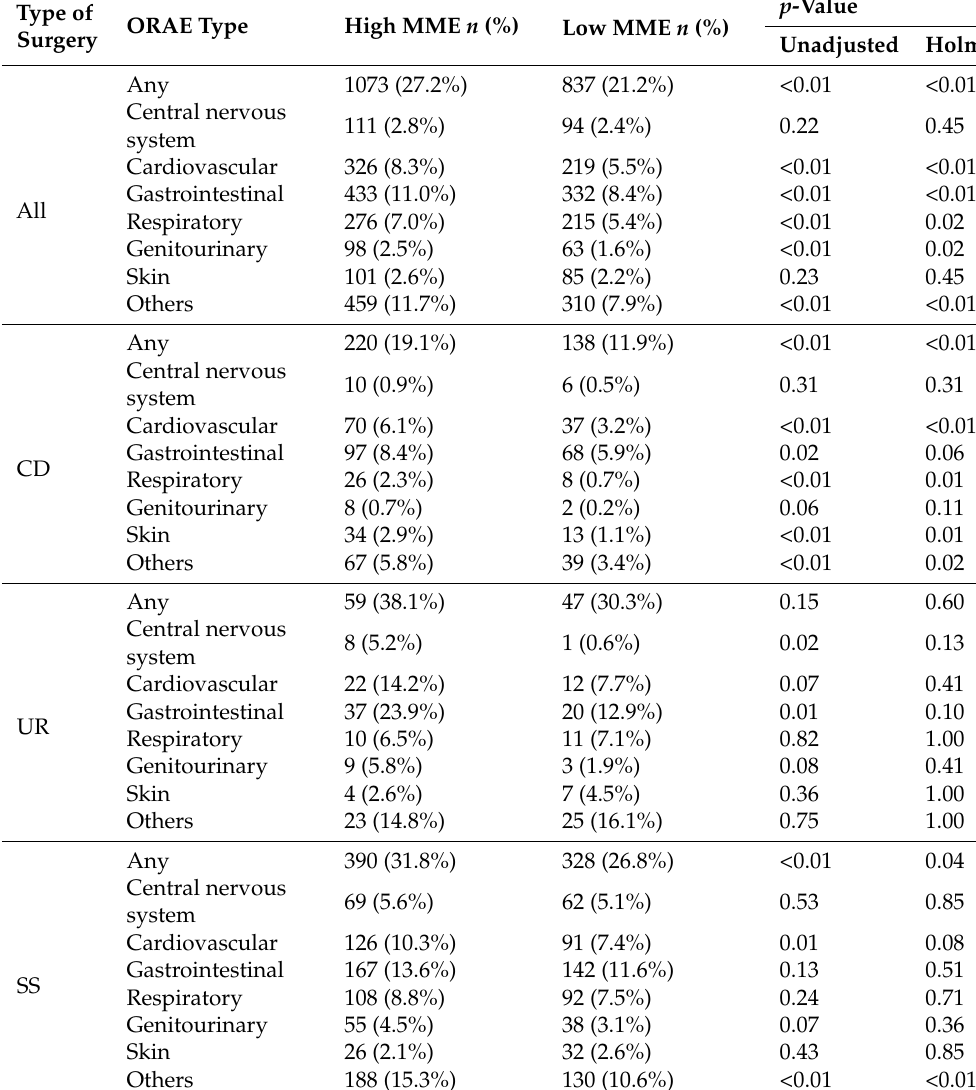
Table 3. Patients who had one or more diagnosis of ORAE during the 180 days after index